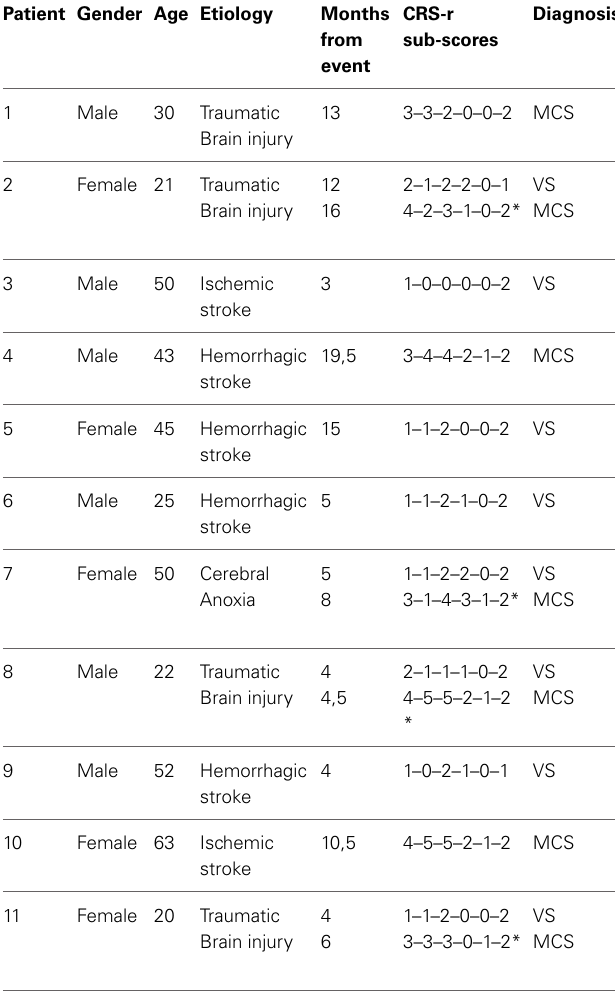
Asterisks indicate the CRS-R scores relative to the second evaluation session, performed in patient 2, 7, 8, and